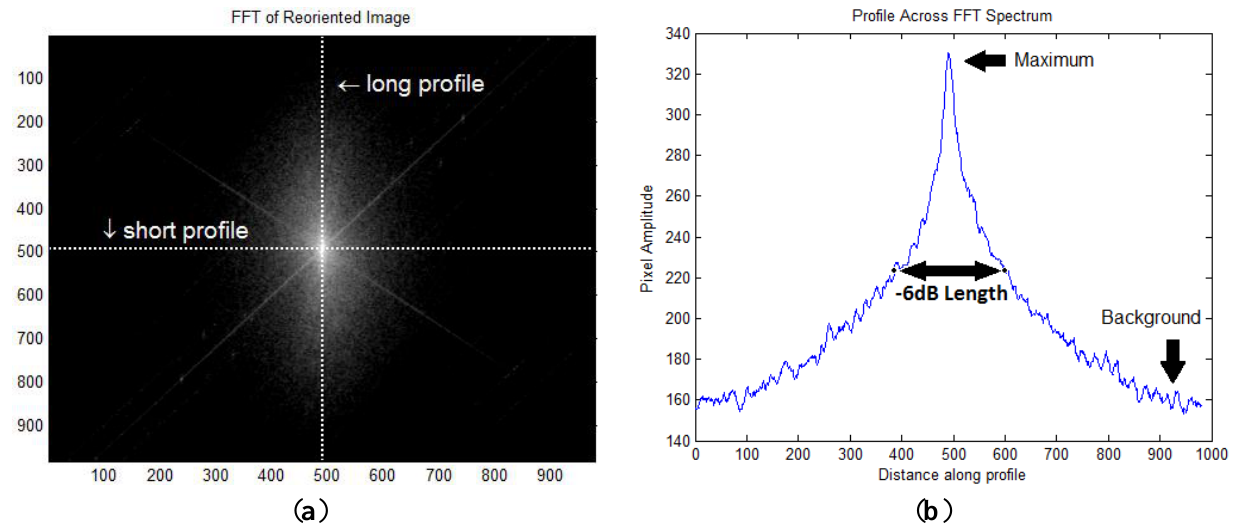
Figure 10. Measuring the short and long profiles ( a ) A FFT of an image of skin in which the lowest frequencies have been shifted to the center of the image. Two profiles (short and long) can be defined with respect to the induced strain; ( b ) When the short profile is examined, the FWHM (or –6 dB length) is a pixel distance between values which are half the amplitude between the maximum and